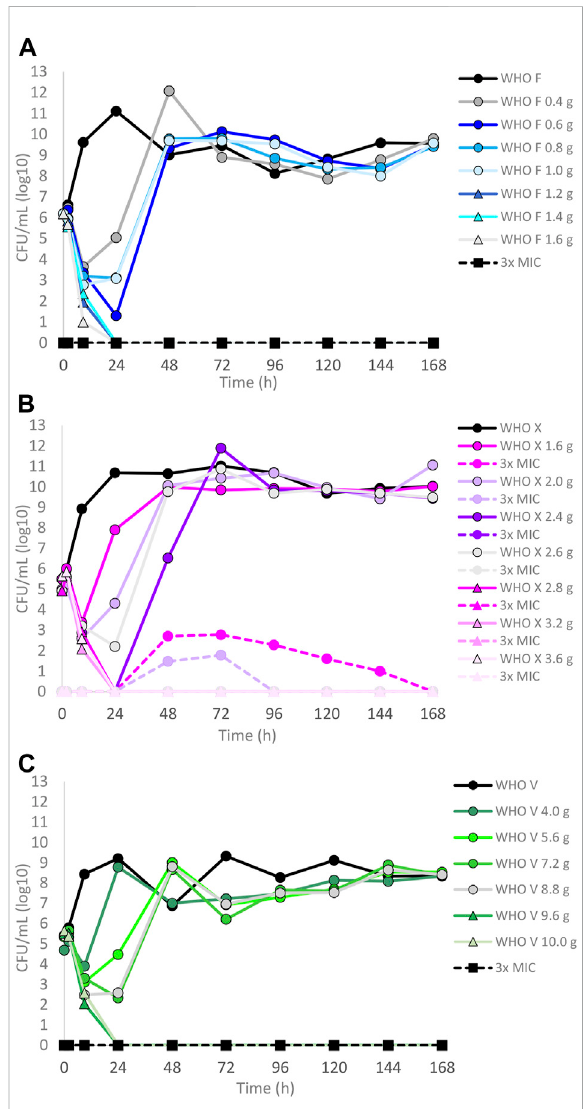
FIGURE 2 Growth curves of the total population of the Neisseria gonorrhoeae WHO X reference strain in the hollow fi ber infection model (HFIM) experiments simulating free (12% protein-unbound) (A) lefamulin single oral dose of 2.4, 2.8, 3.2, and 3.6 g, (B) lefamulin oral daily dose of 2.4, 2.8, 3.2, and 3.6 g administered as equally divided doses q12 h for 7 days, and (C) lefamulin oral daily dose of 2.4, 2.8, 3.2, and 3.6 g administered as equally divided doses q8 h over 24 h for 7 days. All experiments were followed for 7 days. The total growth of the untreated control (black solid line) and total growth of lefamulin-resistant populations (dashed lines) on the lefamulin-containing plates (3 ×MIC) are also shown for each